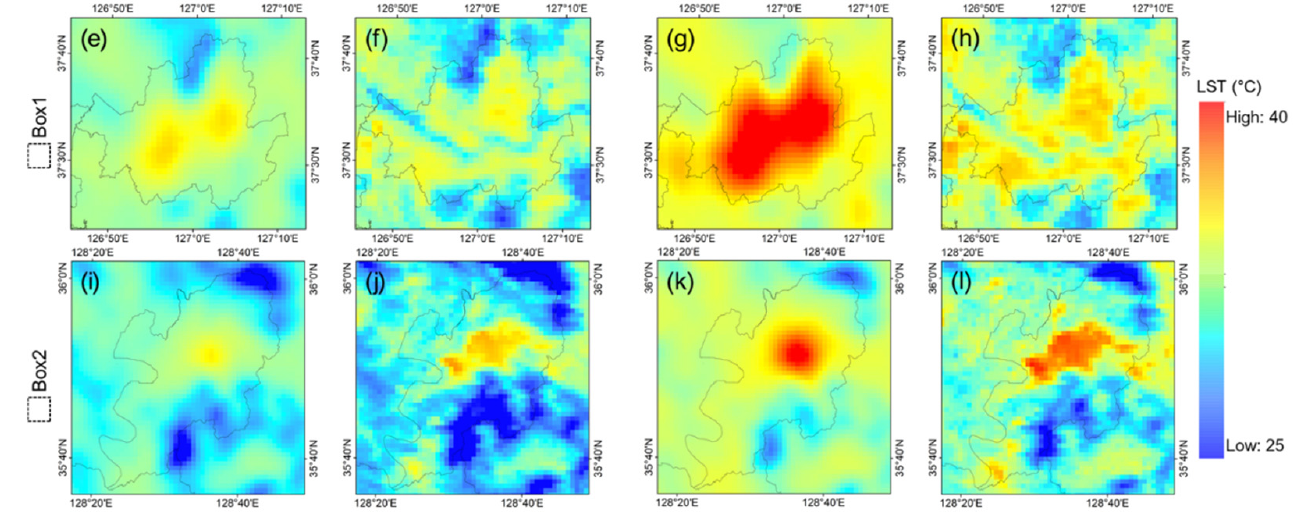
Figure 8. Spatial distribution of the average all-sky 1 km LSTs for Terra and Aqua nighttime produced by ( a , c ) LDAPS and ( b , d ) LightGBM in June–August from 2013 to 2020. The enlarged LST distributions of ( e , g , i , k ) LDAPS and ( f , h , j , l ) LightGBM are shown for two subset areas (i.e., boxes 1 and 2), which are representative metropolitan areas in South Korea that often suffer from summer heatwaves.